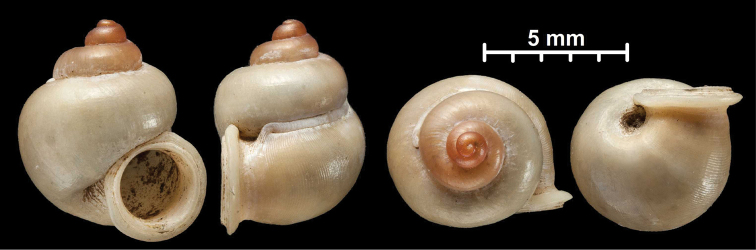
Dioryx
amphora (Benson, 1856), probable syntype (UMZC I.102850; type species of Dioryx). Photographs: Harold Taylor (NHM).